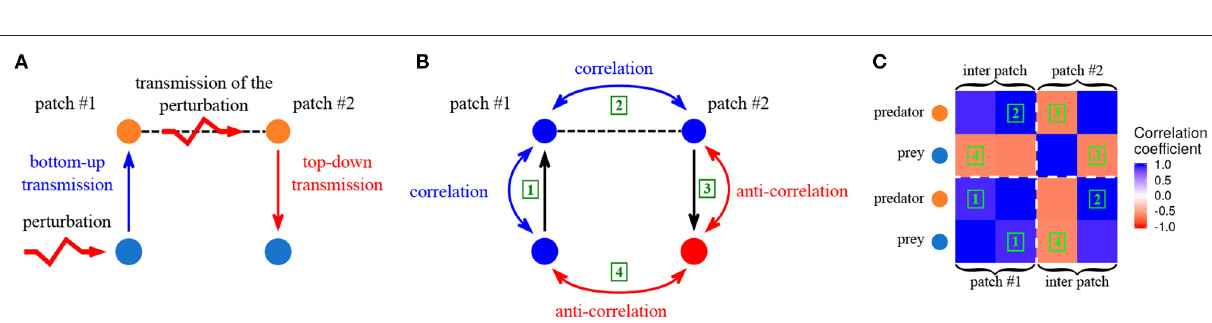
FIGURE 3 | Synchrony in a two-patches predator prey metacommunity. Only predators are able to disperse and prey receive stochastic perturbations in patch #1. (A) Propagation of perturbations from patch #1 to patch #2. (B) Correlation between the various populations in response to perturbations. (C) Correlation matrix of the metacommunity. Each colored square represents the correlation coefficient between two populations. The green numbers correspond to the correlations showed in (B) , for instance, squares labeled with 1 are the correlation between prey and predators in patch #1. The diagonal blocks (delimited by white dashed lines) represent the correlation of populations within the same patch, while the off-diagonal blocks represent the correlation of populations belonging to different patches. ( ε a ma 10 and d 2 10 3 , from Quévreux et al., = =